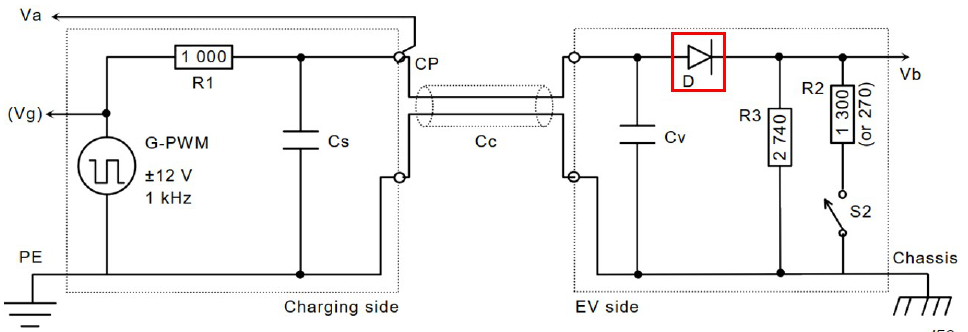
Figure 7. Typical control pilot circuit (equivalent circuit) highlighting the missing diode in the BYD